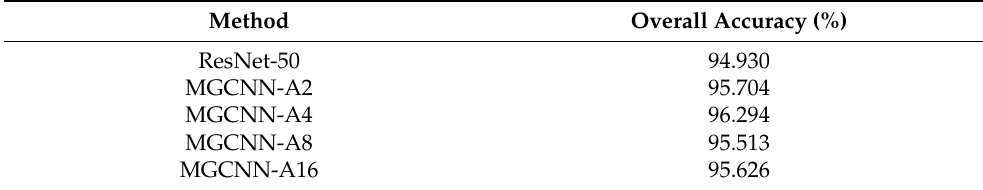
Table 4. Overall accuracy (OA) of